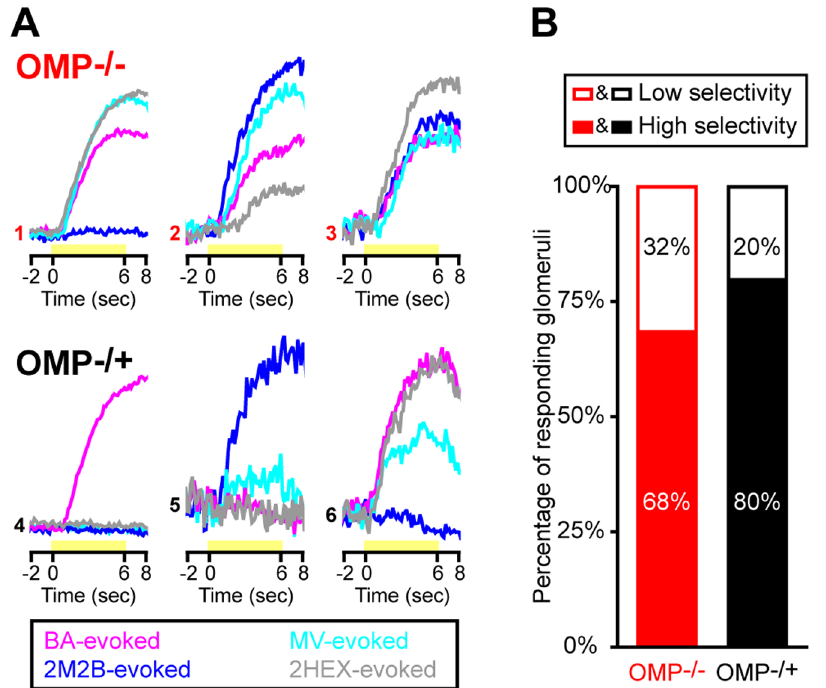
Figure 2. Odorant response selectivity is reduced in glomeruli from OMP 2 / 2 mice. ( A ) Example odorant response selectivity patterns in 6 individual glomeruli; 3 OMP 2 / 2 glomeruli ( top row , traces 1–3) and 3 OMP 2 / + glomeruli ( bottom row , traces 4–6). Each set of 4 traces corresponds to a single glomerulus’ responsivity to 4 test odorants that were all presented at a concentration of 30 a.u.: butyl acetate ( BA, magenta ), methyl valerate ( MV, cyan ), trans -2-methyl-2-butenal ( 2M2B, blue ), and 2-hexanone ( 2HEX, grey ). Each set of traces is scaled relative to the maximum evoked response across all 4 odorants per glomerulus. Yellow bars indicate the time when odor stimuli were presented. ( B ) Percentage of OMP 2 / 2 ( red ) and OMP 2 / + ( black ) glomerular populations that were categorized as having higher ( closed bars ) or lower ( open bars ) odorant response